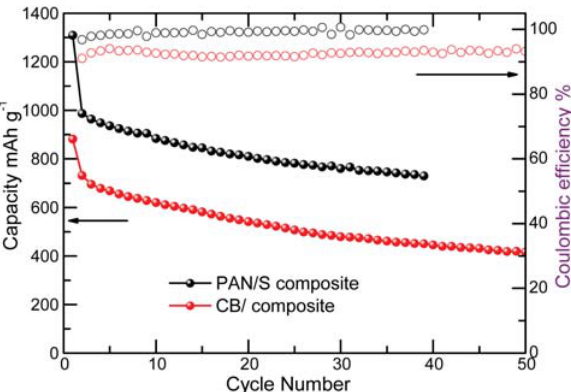
Figure 3. Discharge capacity (left axis) and coulombic efficiency (right axis) of PAN/S and carbon/S based composites for 50